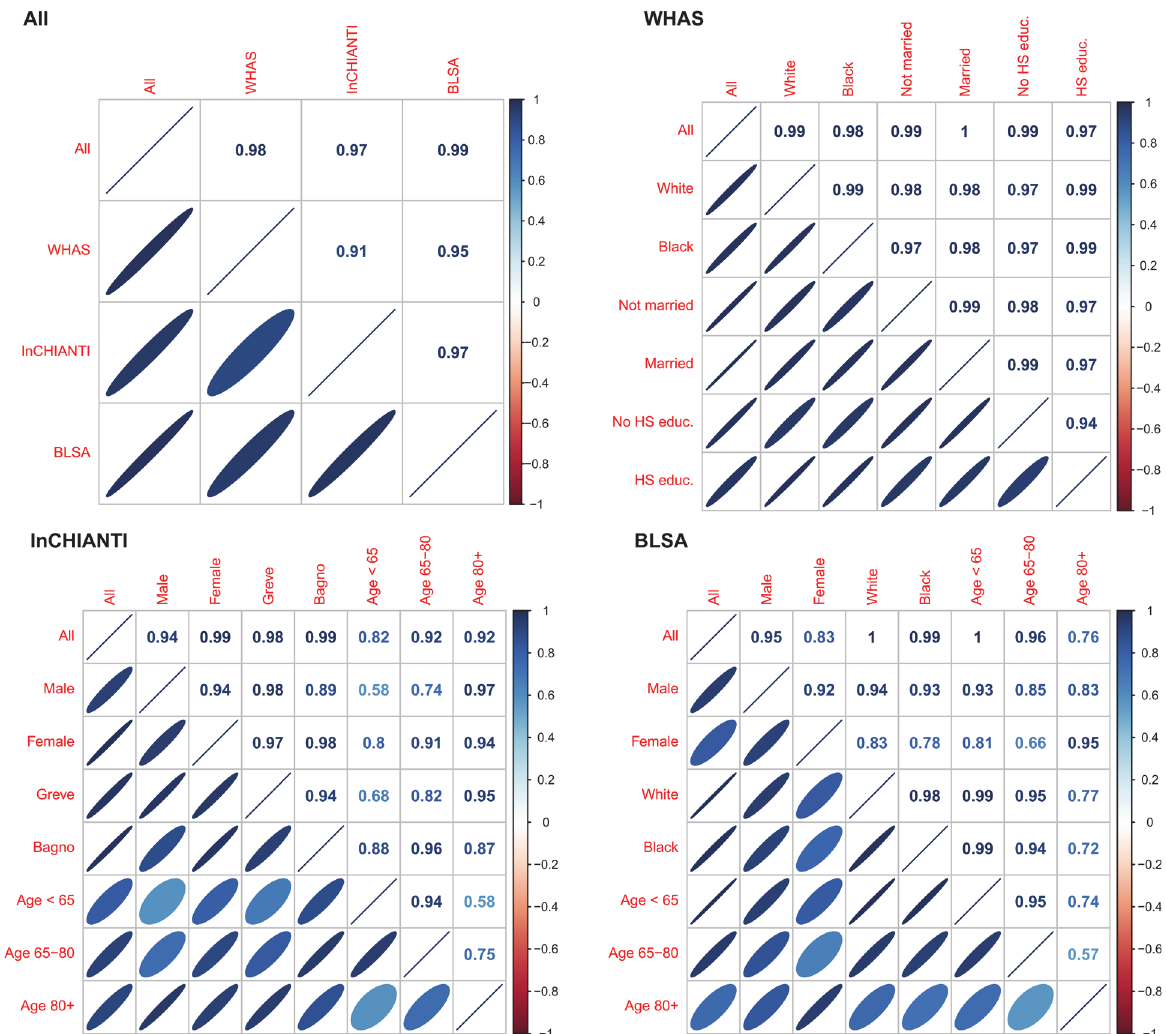
Fig 6. Correlations among versions of PCA1 calculated from the full merged 43-variable dataset or from data subsets. The loadings from each subset-based PCA are reapplied to randomly selected visits of the full dataset to calculate the scores used in the correlations [27,28]. Ellipses below the diagonal indicate correlations visually: blue when positive, red when negative, and darker and narrower when stronger. Correlation coefficients are above the diagonal. For all panels except BLSA, the 43-variable set is used; for BLSA there was insufficient sample size to perform PCA on subsets with 43 variables, so the 34-variable analysis is